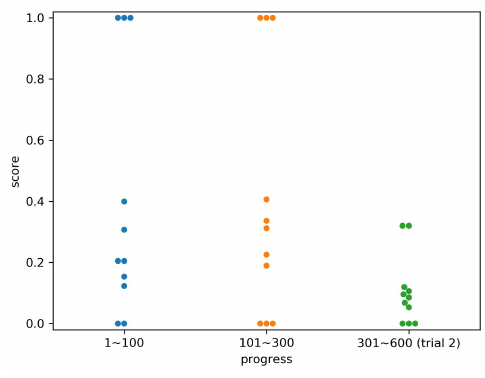
Figure 16. Scores of Subject 6 by time period.